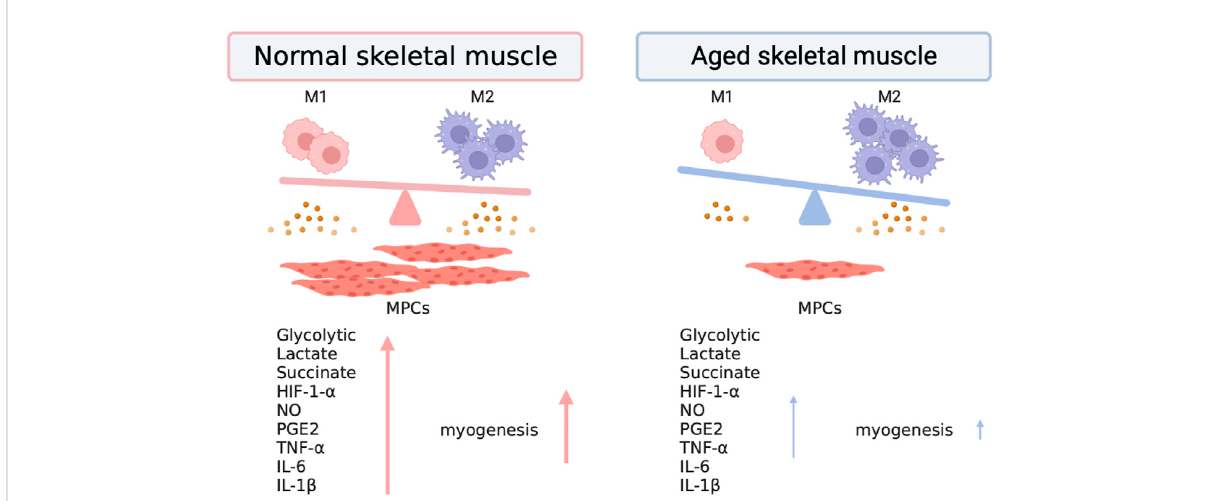
FIGURE 1 Skewed metabolic regulation and cytokine production in macrophages impairs skeletal muscle regeneration. Pro-in fl ammatory macrophages exhibit increased glucose uptake and glycolysis, leading to the accumulation of lactate and entry of glucose-derived pyruvate into the TCA cycle. Succinate accumulation in pro-in fl ammatory macrophages stabilizes HIF-1 α , whereas anti-in fl ammatory macrophages increasethe uptakeof lipids and augment fatty acid oxidation. Pro-in fl ammatory macrophages are characterized by glycolytic metabolism, inducible nitric oxide synthase (iNOS) expression, and the production of pro-in fl ammatory cytokines such as TNF- α , IL-6, and IL-1 α . Pro-in fl ammatory macrophages are critical in promoting myogenic precursor cells (MPCs) to enhance skeletal muscle regeneration. However, anti-in fl ammatory macrophages are the dominatingtypeofmacrophageinagedskeletalmuscle;pro-in fl ammatorymacrophagesshowedlowerabundanceinskeletalmuscleanddeclined with age (Cui et al., 2019). Therefore, phenotypic and metabolic skewing may impair skeletal muscle regeneration in the elderly